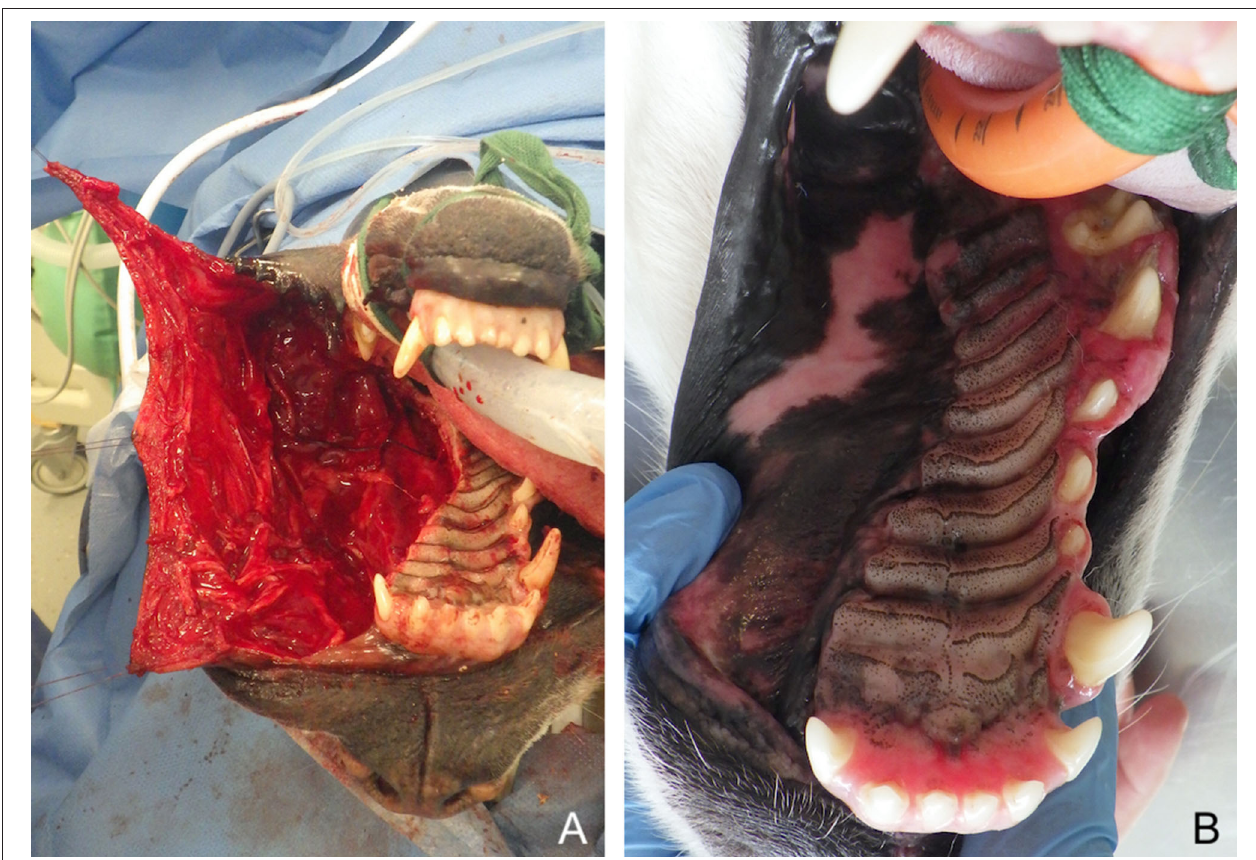
FIGURE 2 | Large myomucosal advancement flap for closure of a unilateral maxillectomy defect (fibrosarcoma) in a dog. (A) Harvesting of the flap and manipulation with stay sutures. (B) 12-months postoperative